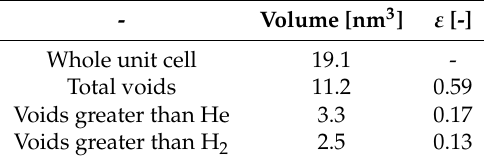
Table 5. Volume portion of the virtual silica membrane structure (2.1 g/ml).